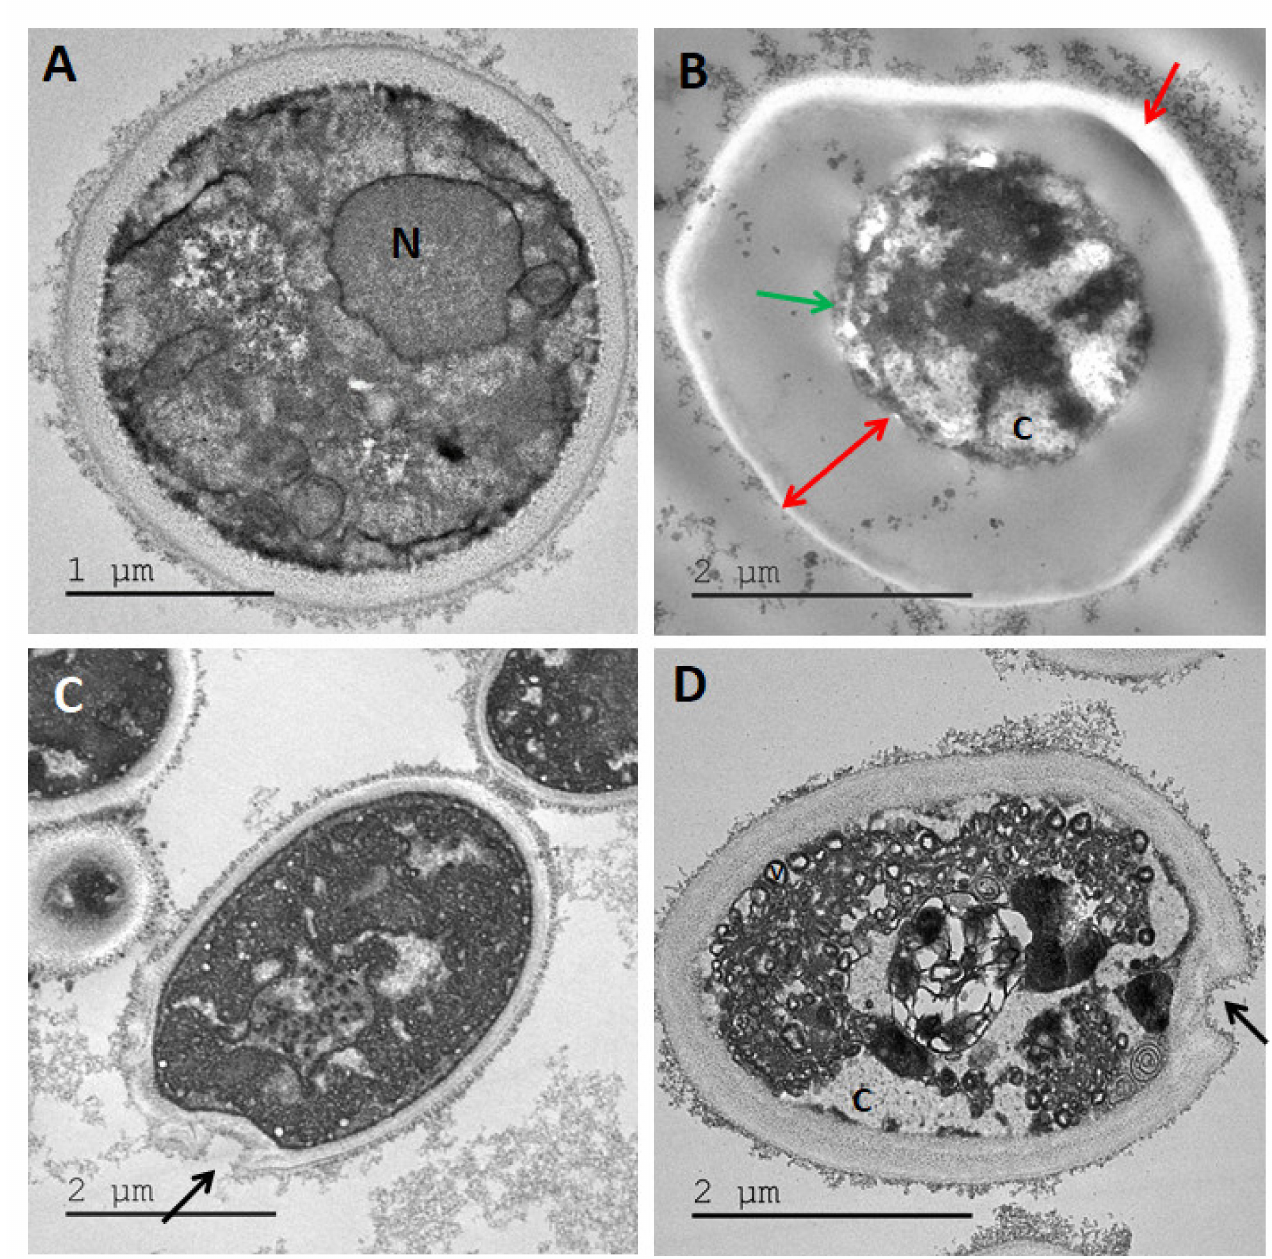
Figure 9. TEM images of Candida albicans treated with ( A ) H 2 0, no treatment control, ( B ) maltol at 4500 ppm, ( C ) DDAC at 500 ppm, ( D ) blend of maltol and DDAC (95:5) at 5000 ppm. Red arrows: alteration of the cell wall structure, receding of cell membrane and thickening of cell wall. Green arrow: lysis of intracellular material. Black arrows: holes in the cell membrane. Abbreviations: C: cytoplasm, N: